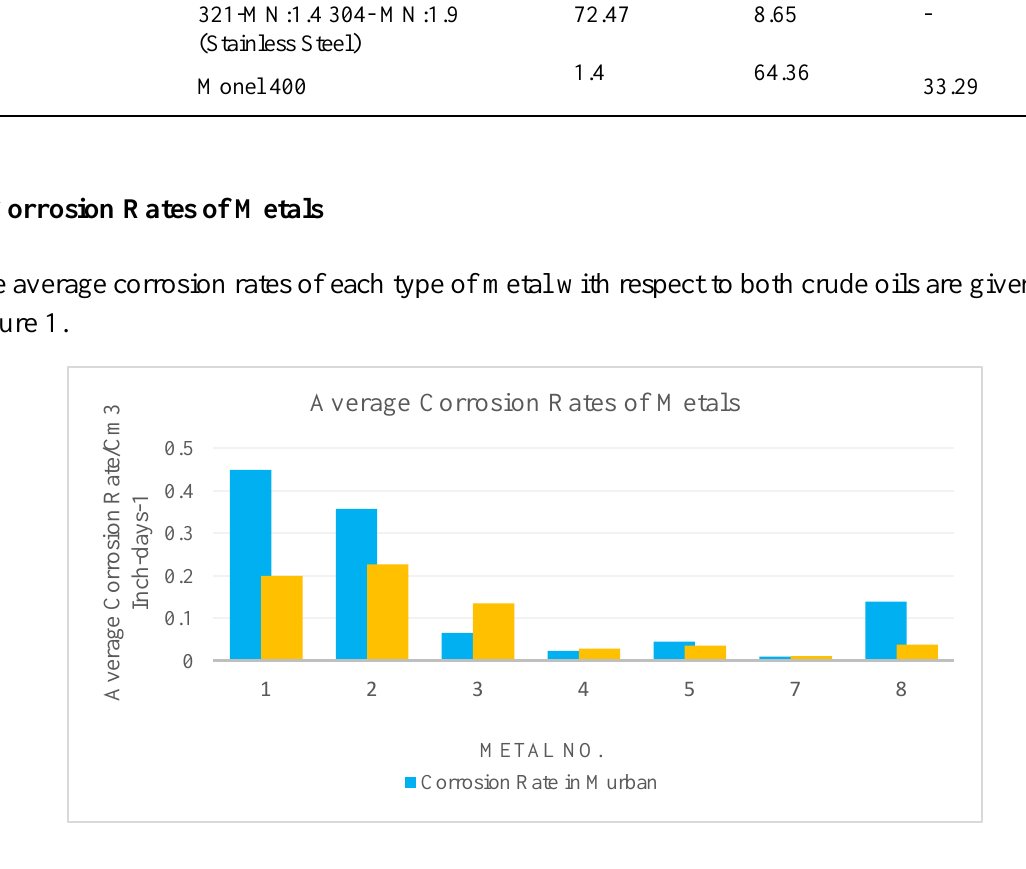
Figure 1. Average corrosion rates of metals in both crude